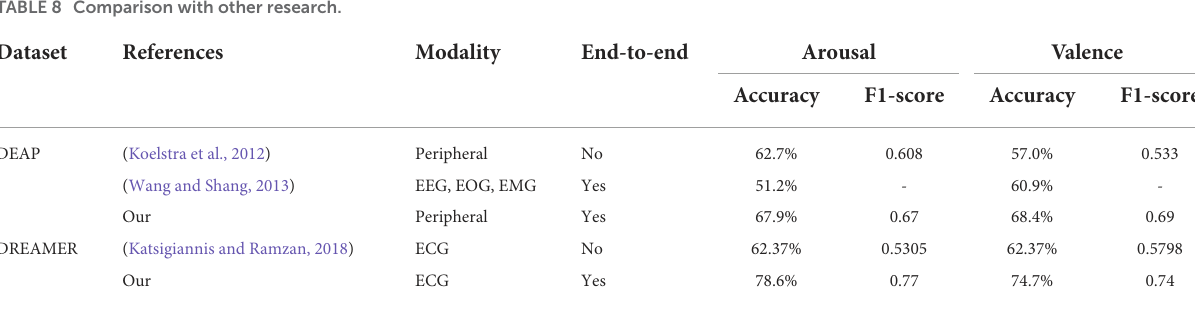
TABLE 8 Comparison with other